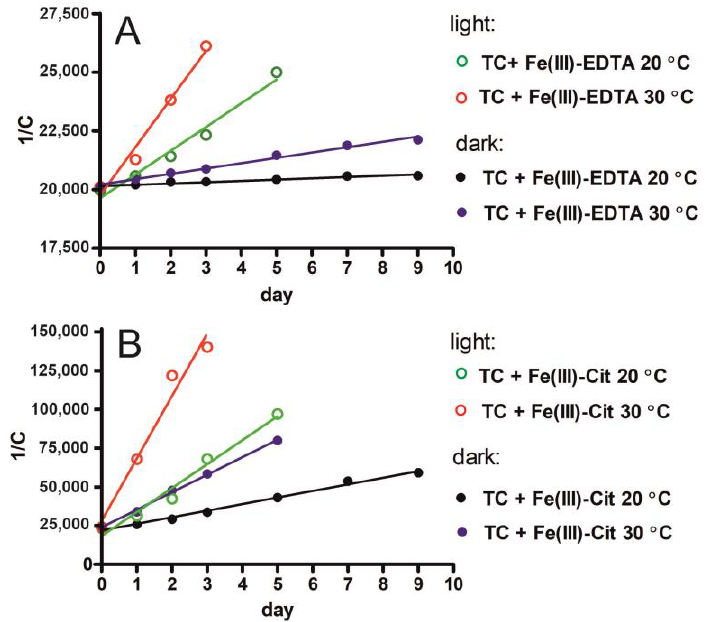
Figure 4. The relationship between TC concentration and time of Fe(III)-EDTA ( A ) and Fe(III)-Cit ( B ) action at various temperatures (20 °C and 30 °C) under light and dark conditions. The following equation was used: 1/C = 1/C 0 + k t.